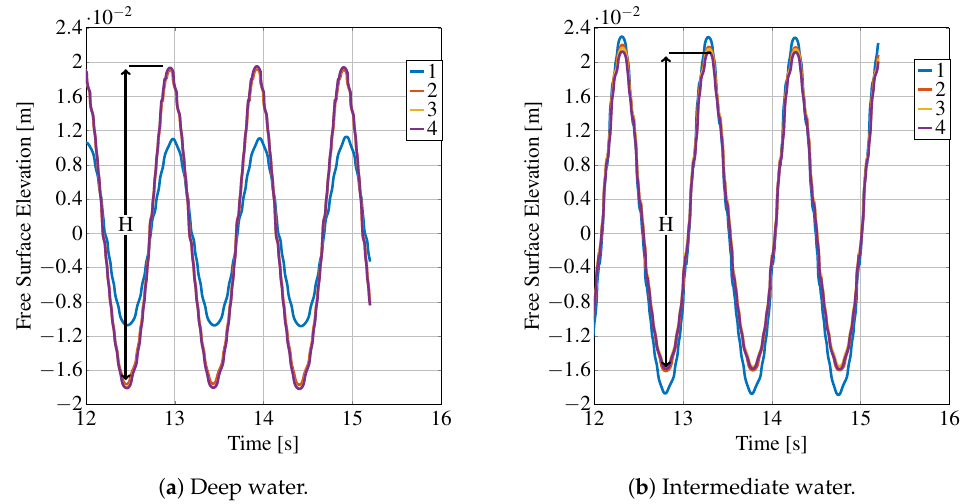
Figure 13. Surface elevation time series for regular waves. Numbers indicate the calibration iteration.